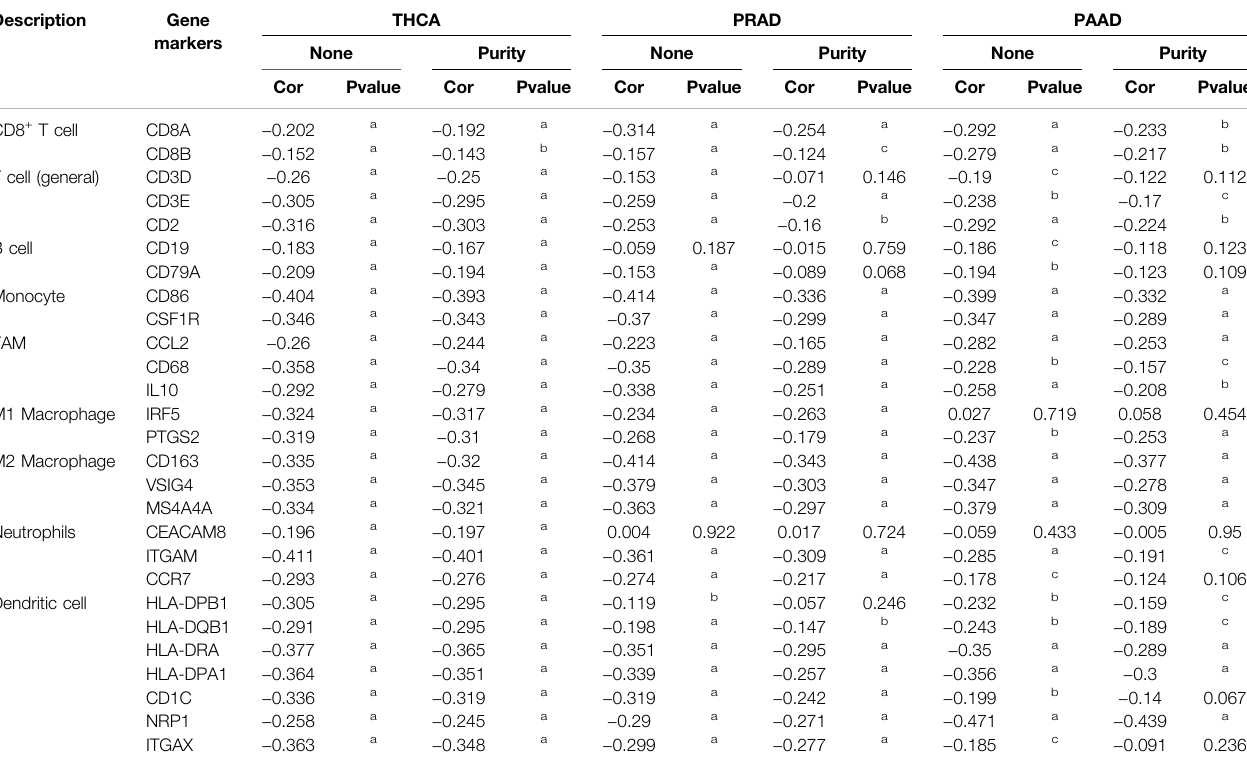
TABLE 1 | Correlation analysis between ALKBH7 and gene markers of immune cells in TIMER. Description Gene